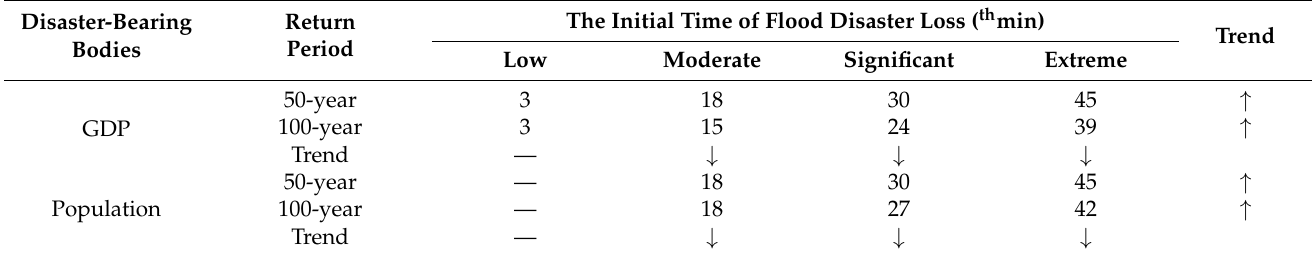
Table 6. The initial moment of flood disaster loss under different flood hazard zones.